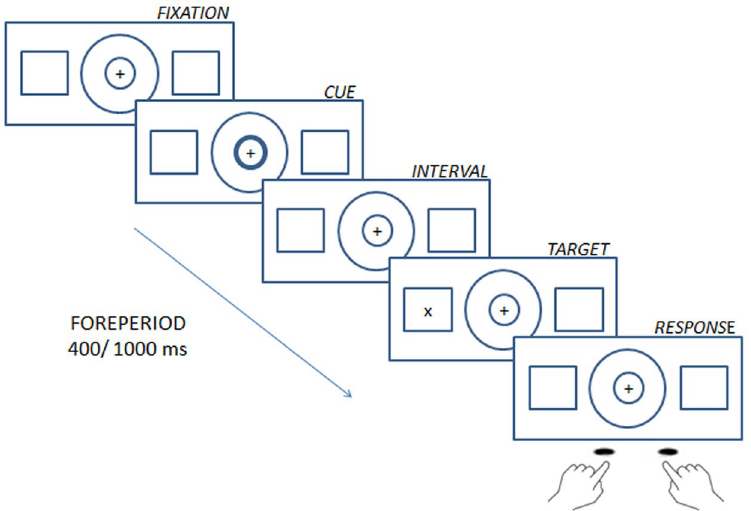
Figure 4. Sequence of events in a trial. Stimuli were presented in grey on a black background.